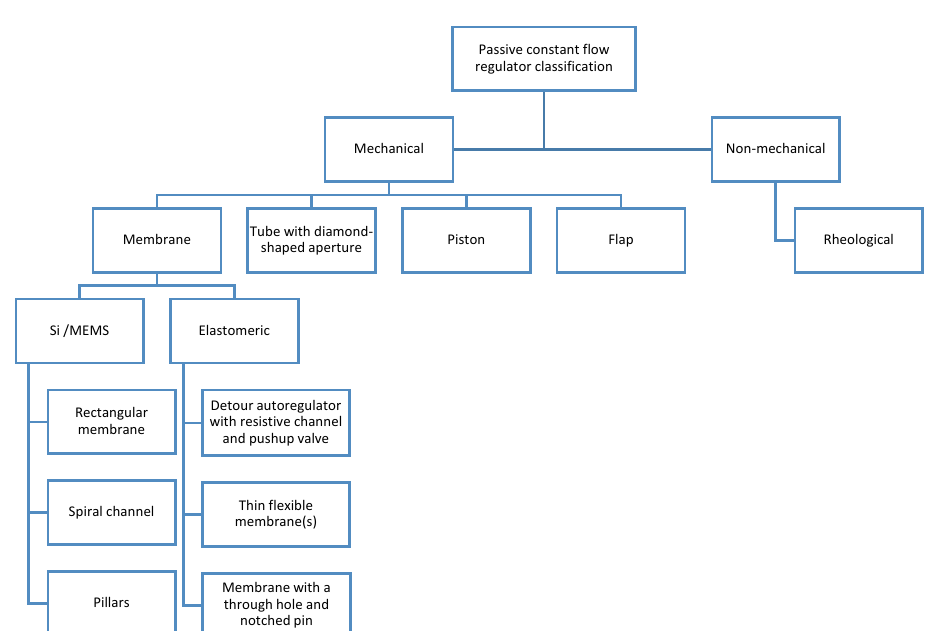
Figure 1. Classification of the passive constant flow regulators dedicated to microfluidic applications.